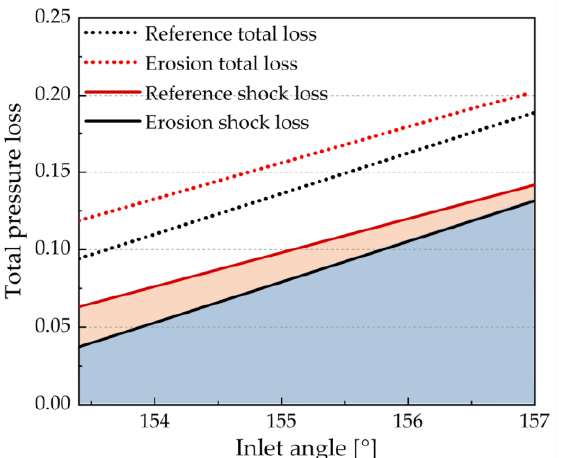
Figure 17. The total and shock loss for reference and eroded blades. Reproduced from [39].